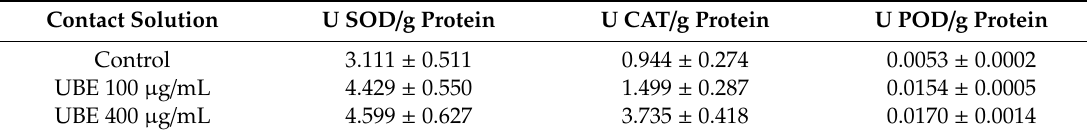
Figure 10. Determination of POD activity (U POD/g protein) under action of different UBE concentrations on CAL 27 cells. The results represent the mean ± SE of three independent experiments (*** p < 0.001) when comparing the effects of UBE with the untreated control (t-test). All the obtained experimental data are presented comparatively in Table 2. Table 2. Comparative antioxidant enzymes activity corresponding to UBE Table 2. Comparative antioxidant enzymes activity corresponding to UBE treatment